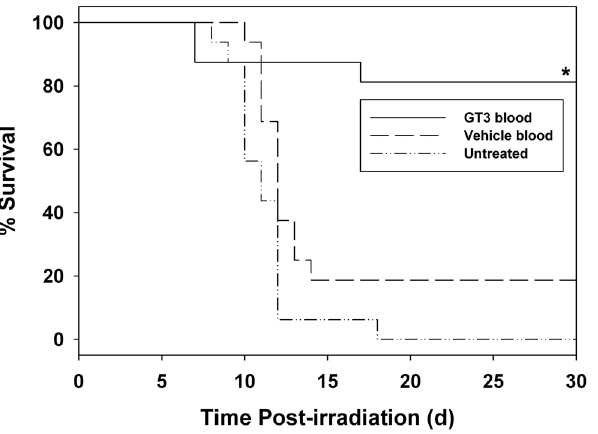
Figure 1. Evaluation of blood from GT3-injected mice as a radiomitigator when administered 24 h after radiation exposure (11 Gy). Mice were transfused (iv) with 100 m l of whole blood. Survival was monitored for 30 days after irradiation. *Denotes statistical significance between GT3-treated and vehicle-treated or untreated groups ( p ,